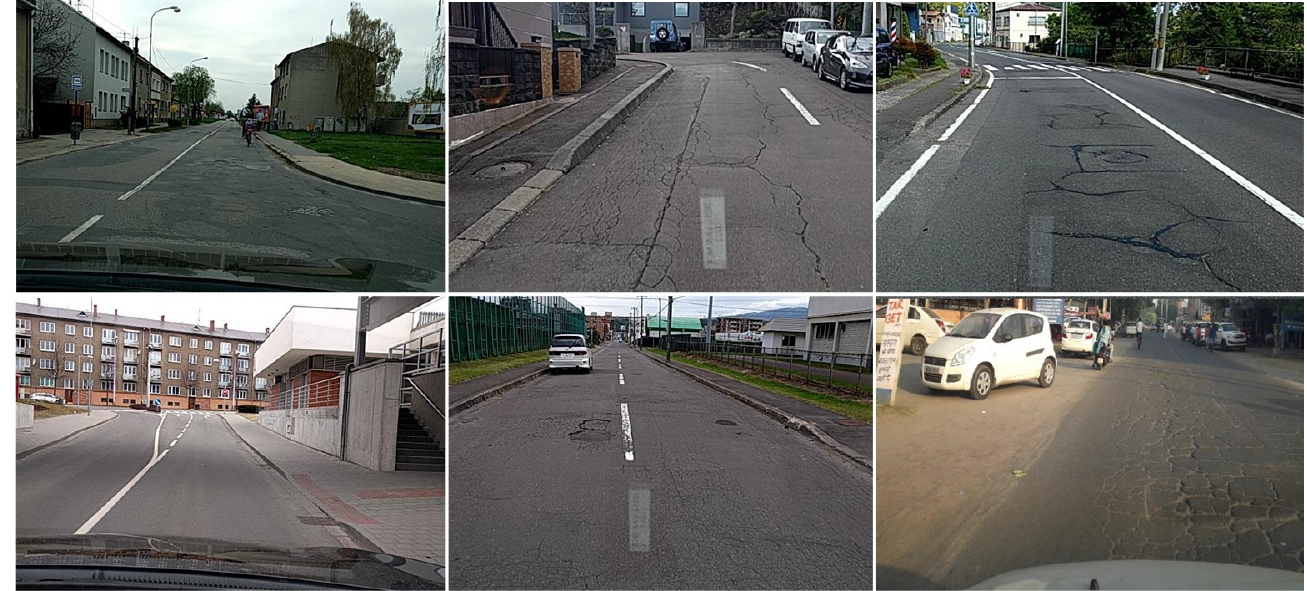
Figure 5. Examples of road images published and collected from Lanzhou by GRDDC 2020.